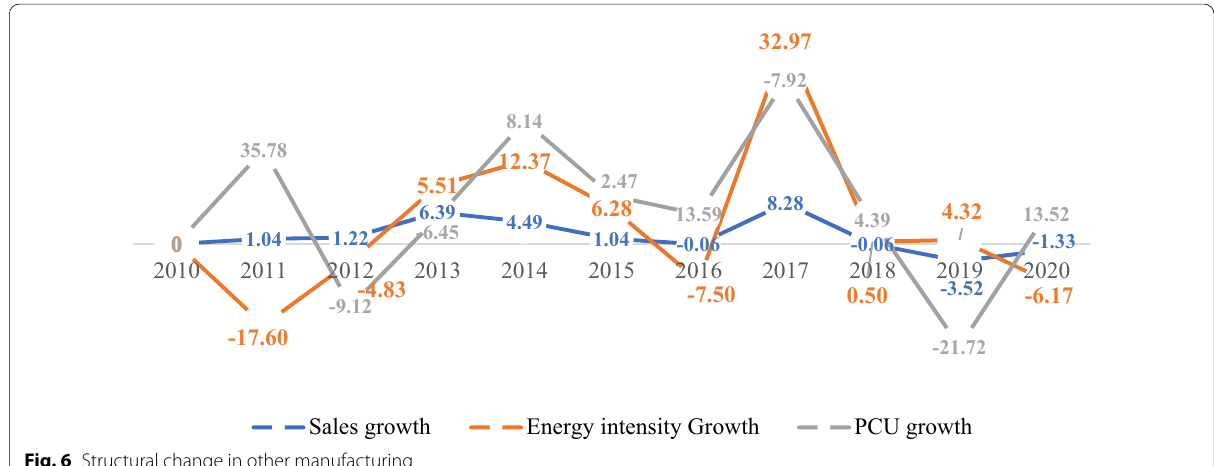
Fig. 6 Structural change in other manufacturing